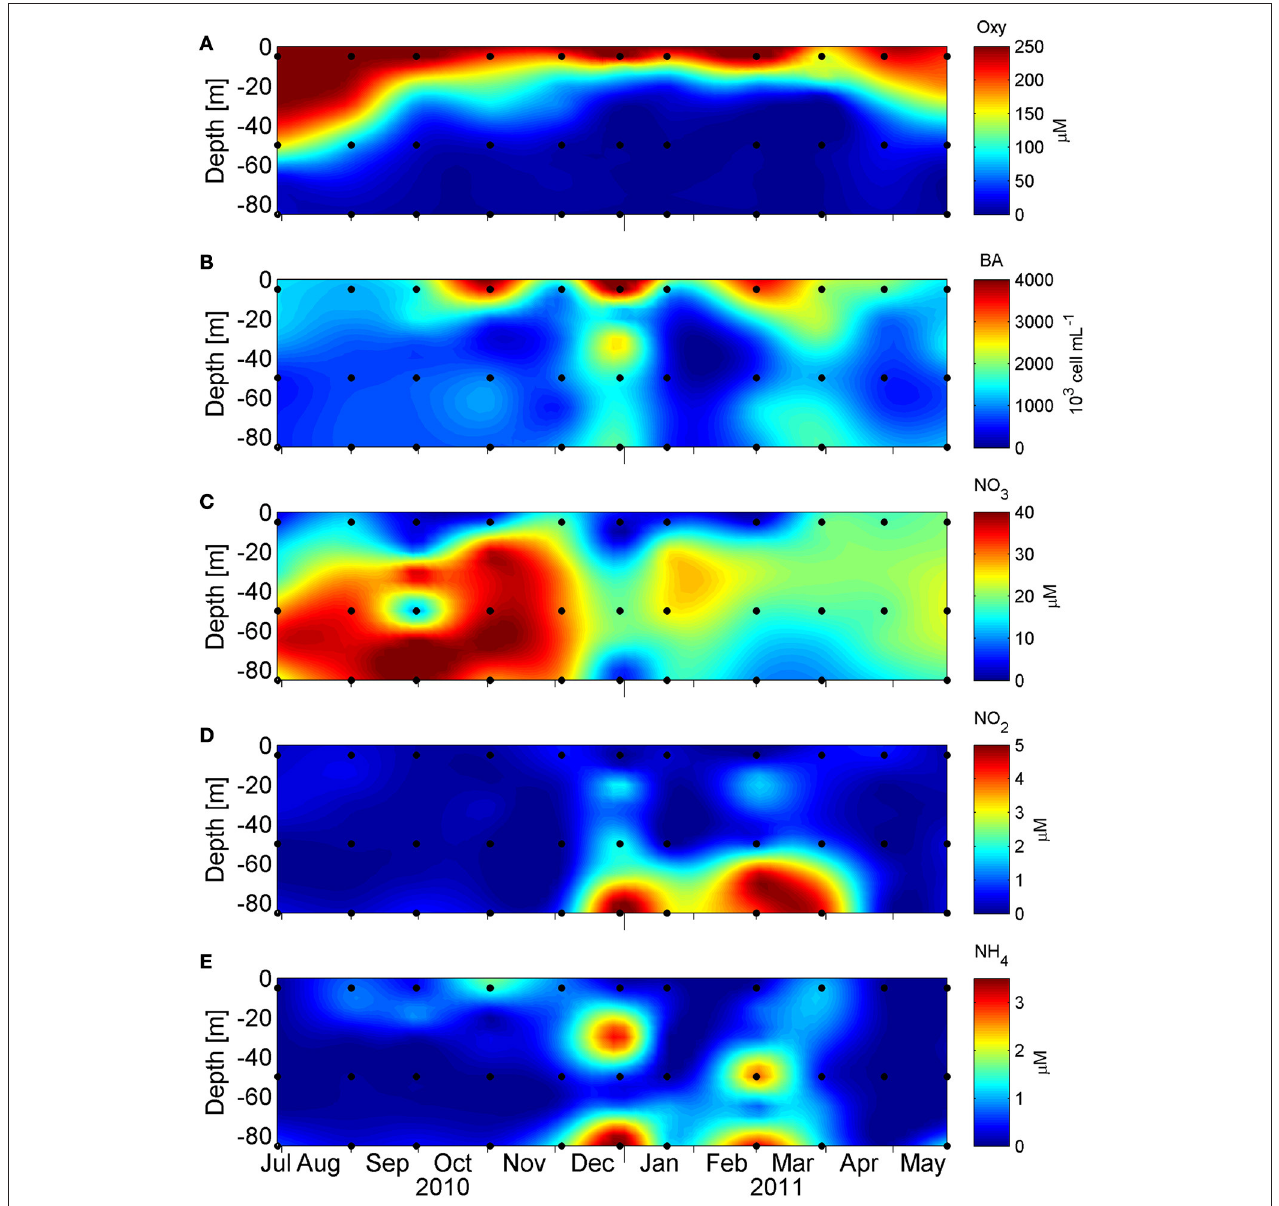
FIGURE 2 | Vertical distribution of (A) dissolved oxygen concentration ( µ M), (B) microbial abundance (10 3 cells mL − 1 ), (C) nitrate concentration ( µ M), (D) nitrite concentration ( µ M) and (E) ammonium concentration ( µ M) in 1 year long, at St. 18. The black dots denote 5, 50, and 85m where the DNA and RNA samples were